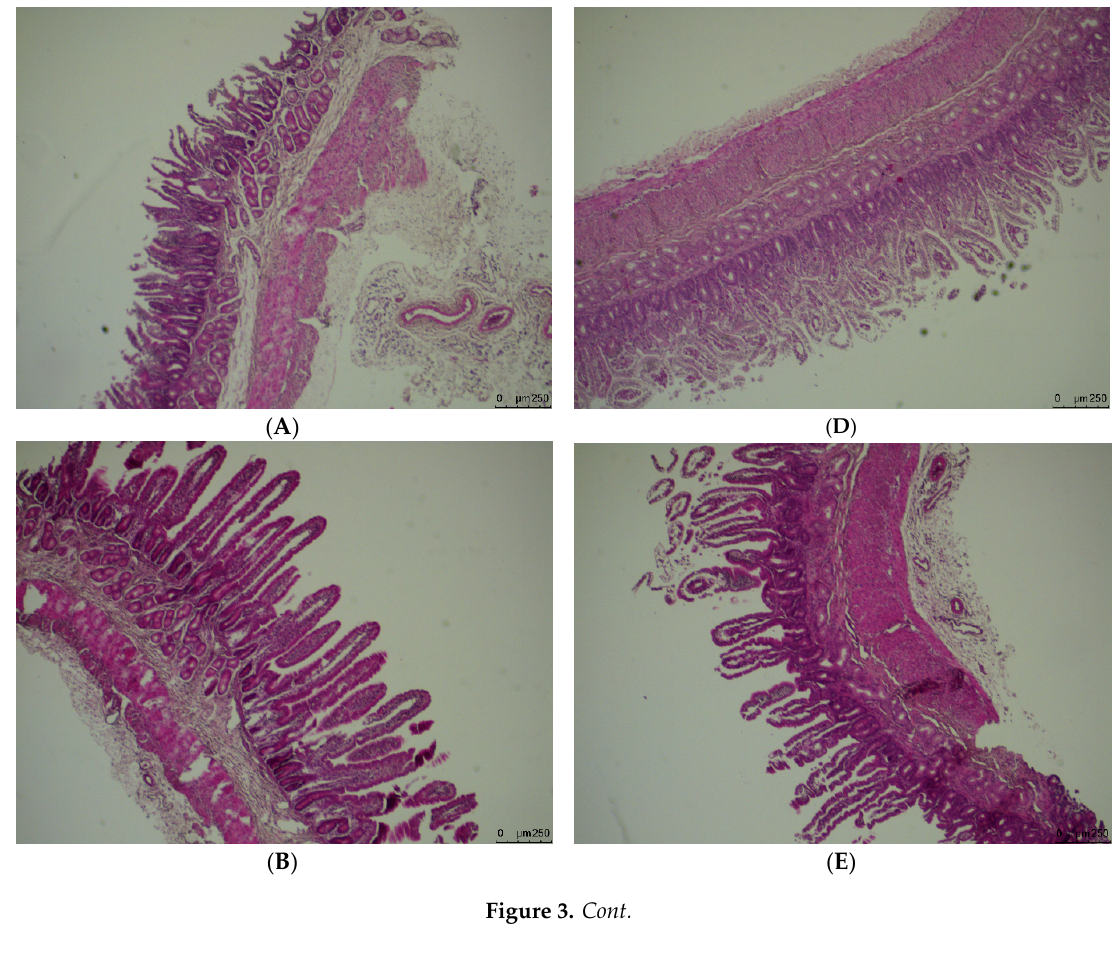
Figure 2. Schematic diagram of small intestinal morphological characteristics.